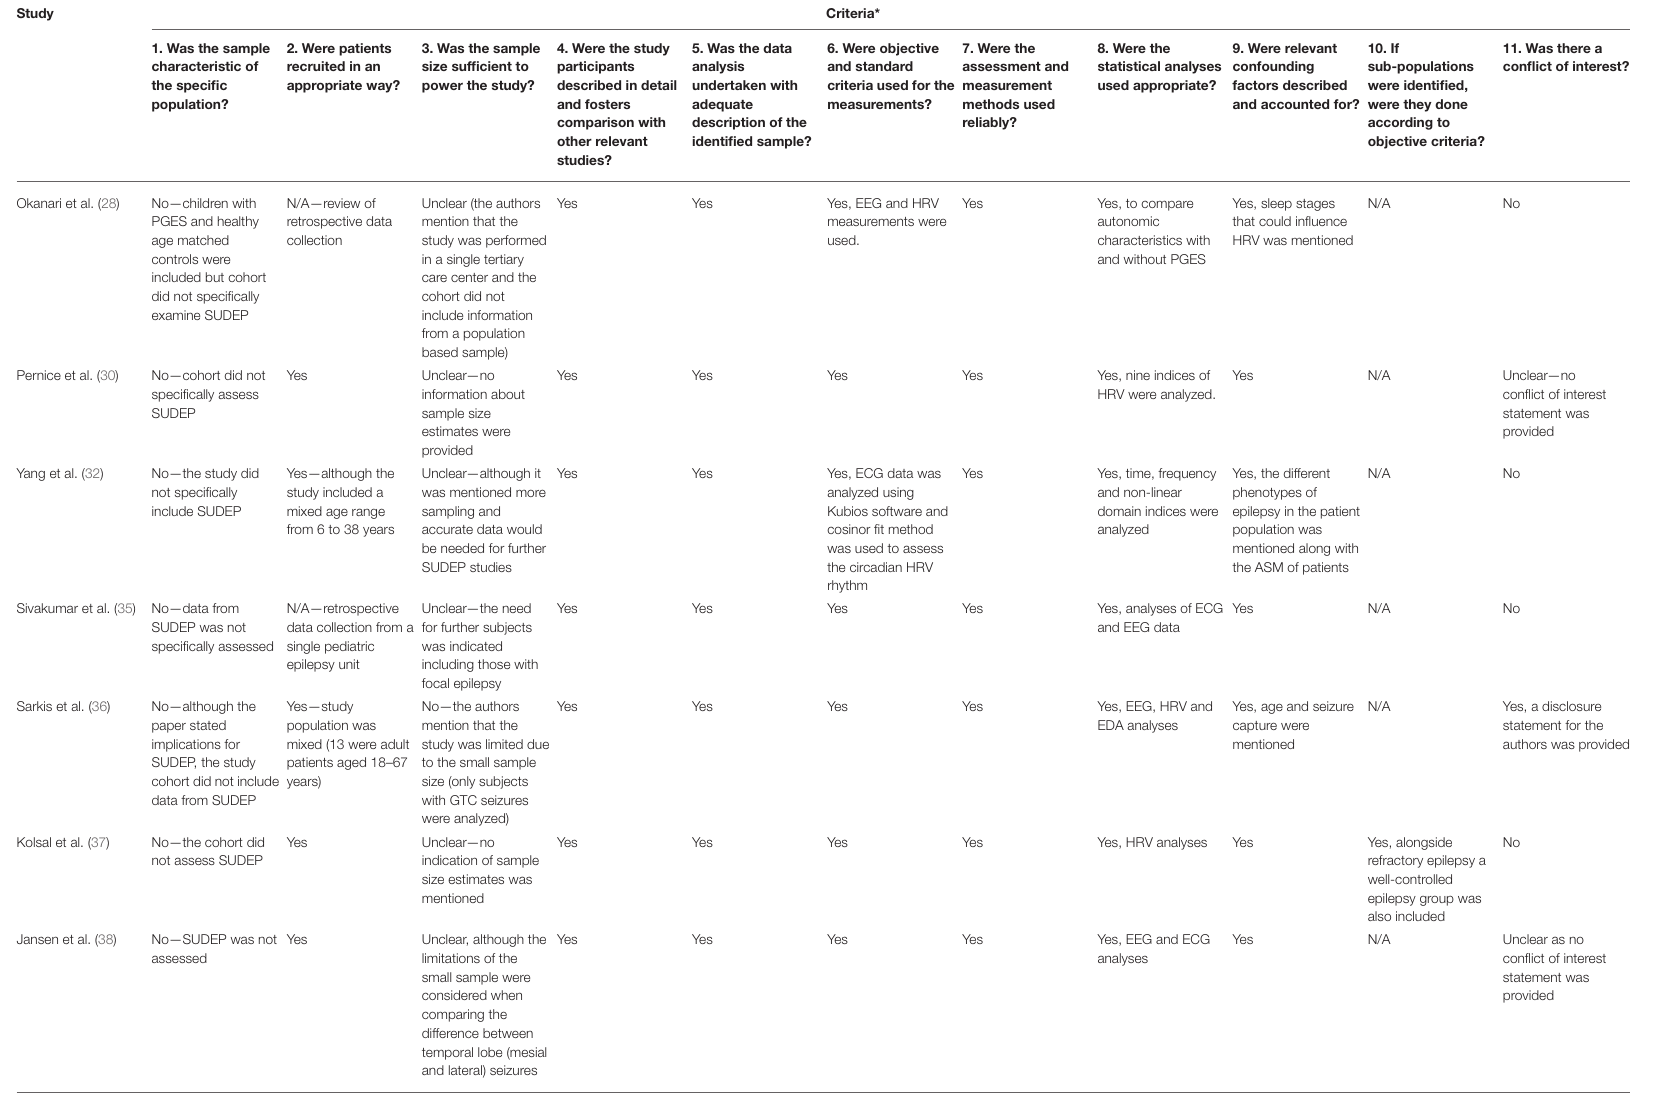
TABLE 2 | Quality assessment of reviewed studies on autonomic characteristics in children with SUDEP.